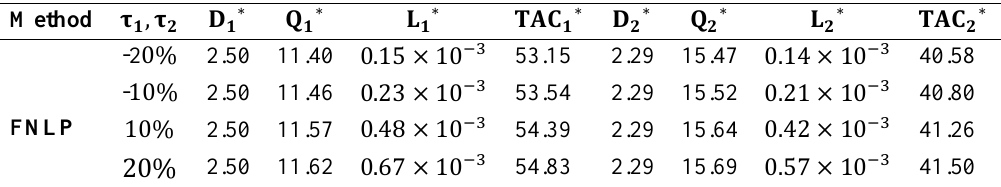
Table 9. Optimal solutions of MOIM for different values of 𝛕 𝟏 , 𝛕 𝟐